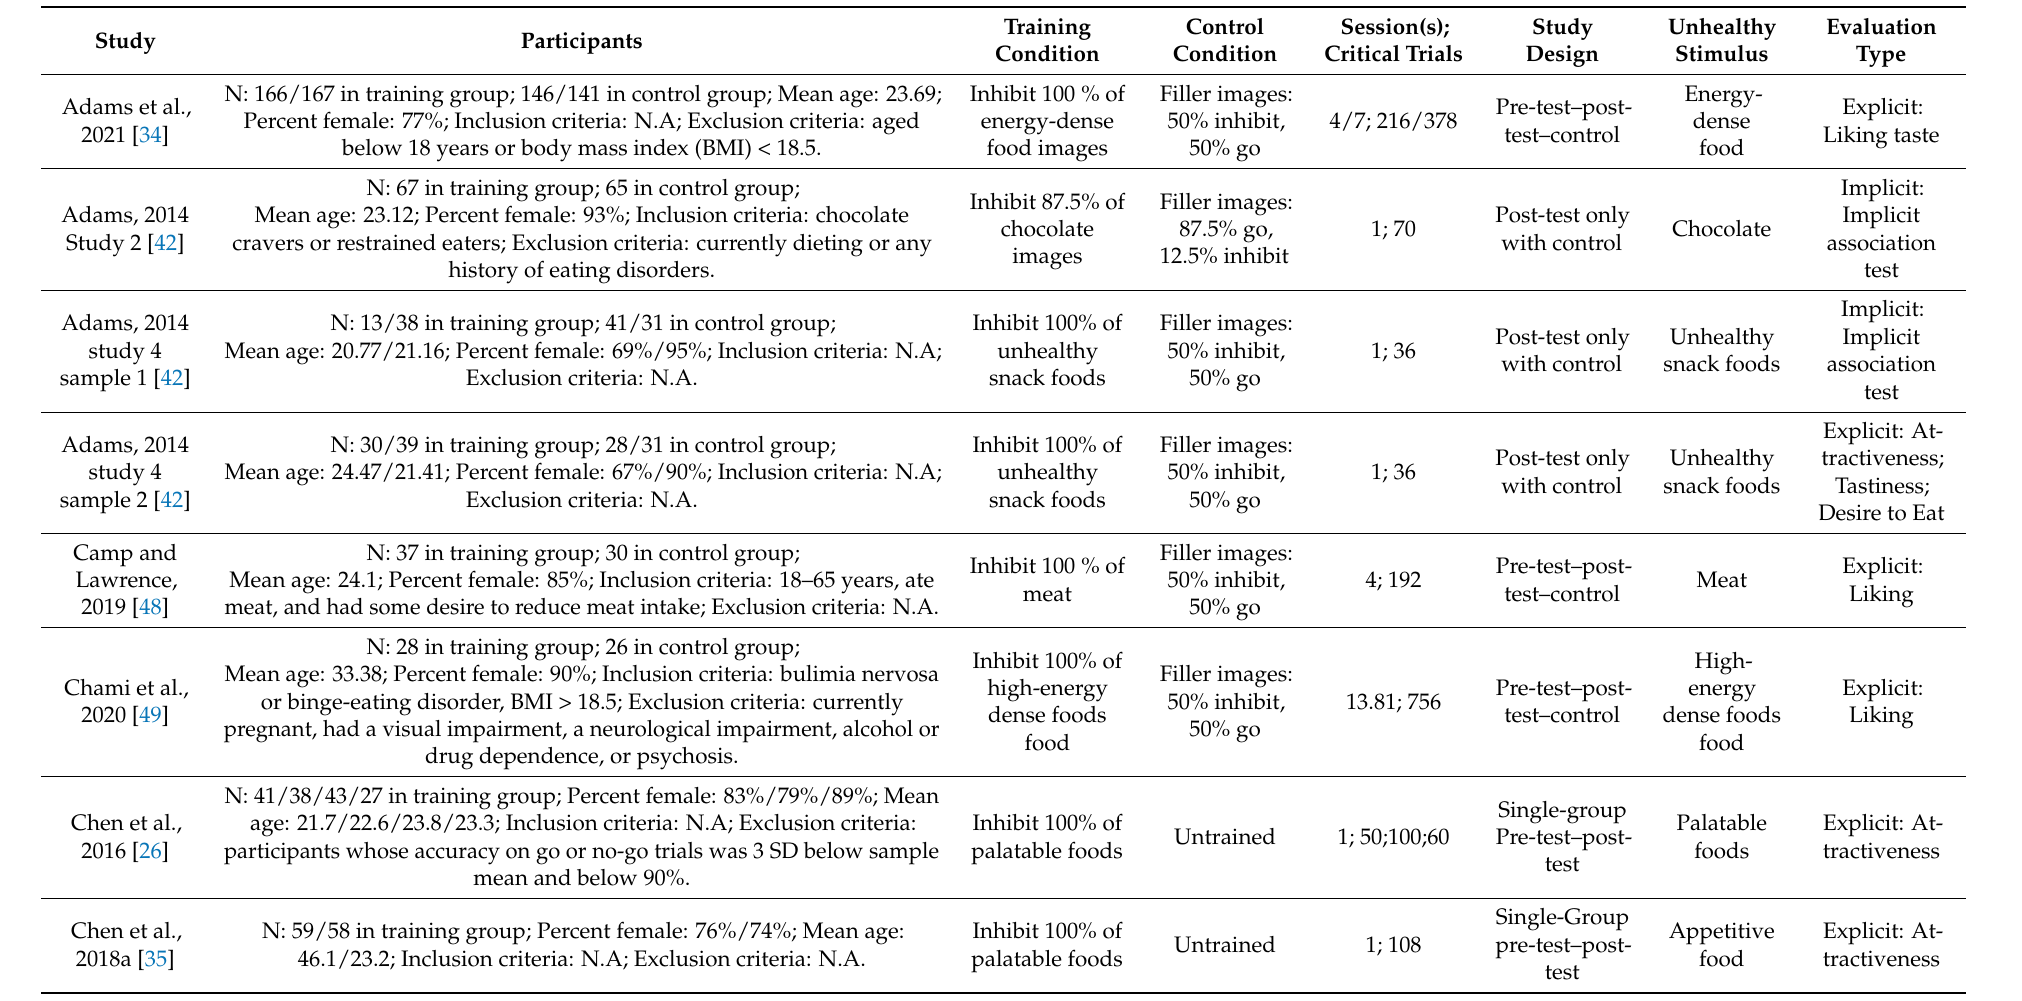
Table 1. Summary of the included papers for the effects of food-specific inhibition training on food